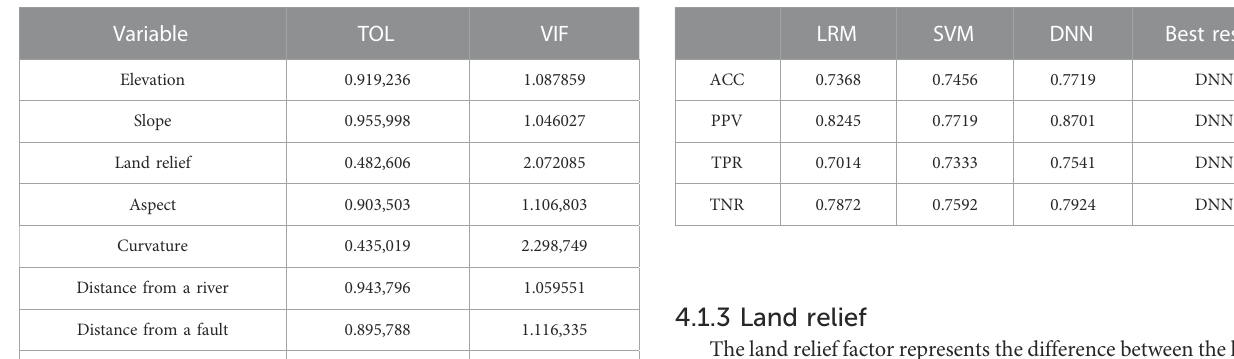
TABLE 2 The factor multicollinearity diagnostics. TABLE 3 Secondary index values of each model in the confusion